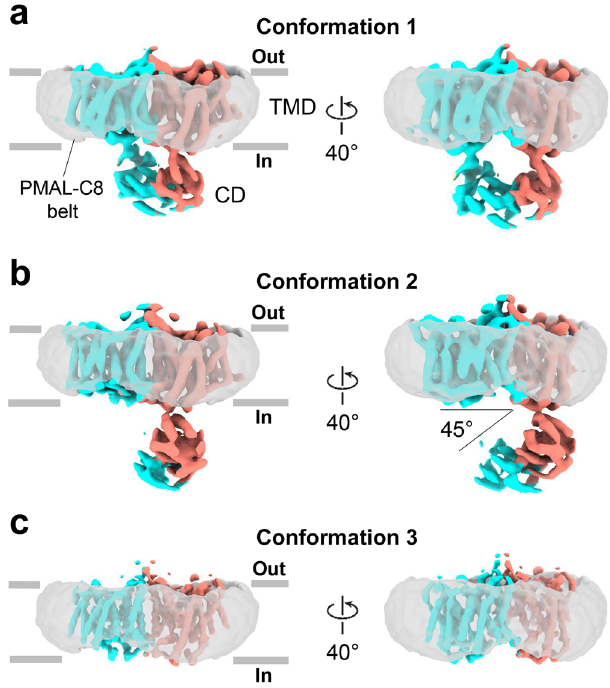
Fig. 1 Structures of the full-length AE1 showing multiple